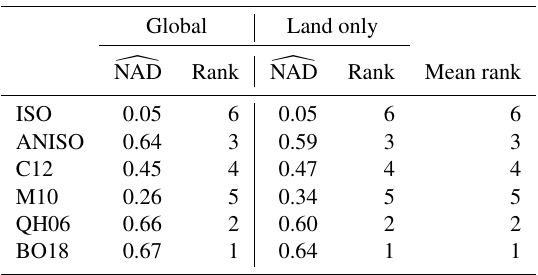
Table 3. Normalized absolute deviation and CERES kernel model candidate